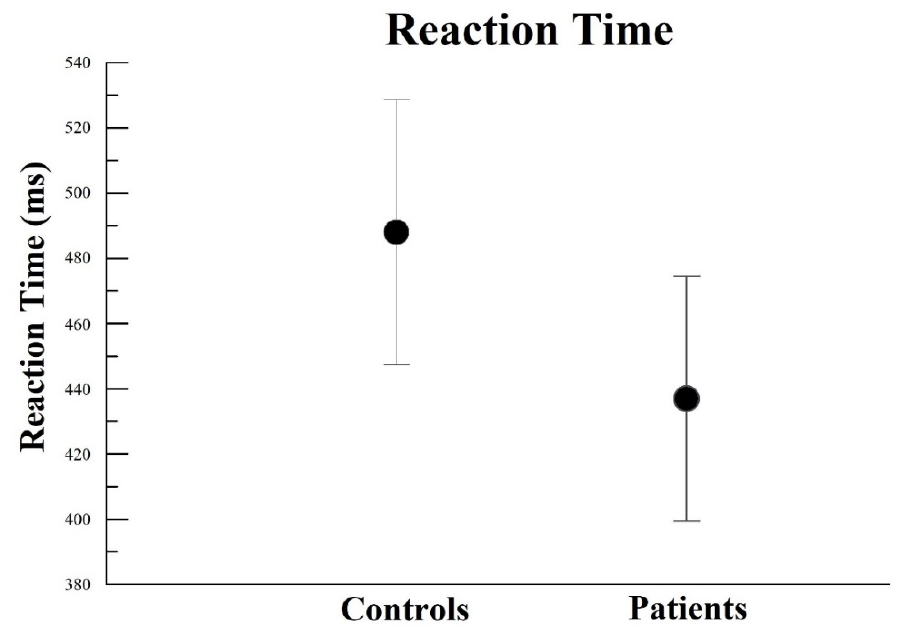
Figure 10. Main effect for group ( p = 0.002). Modification of the reaction time in relation to computer simulation for trigger anxiety. The result is represented by the mean ± standard